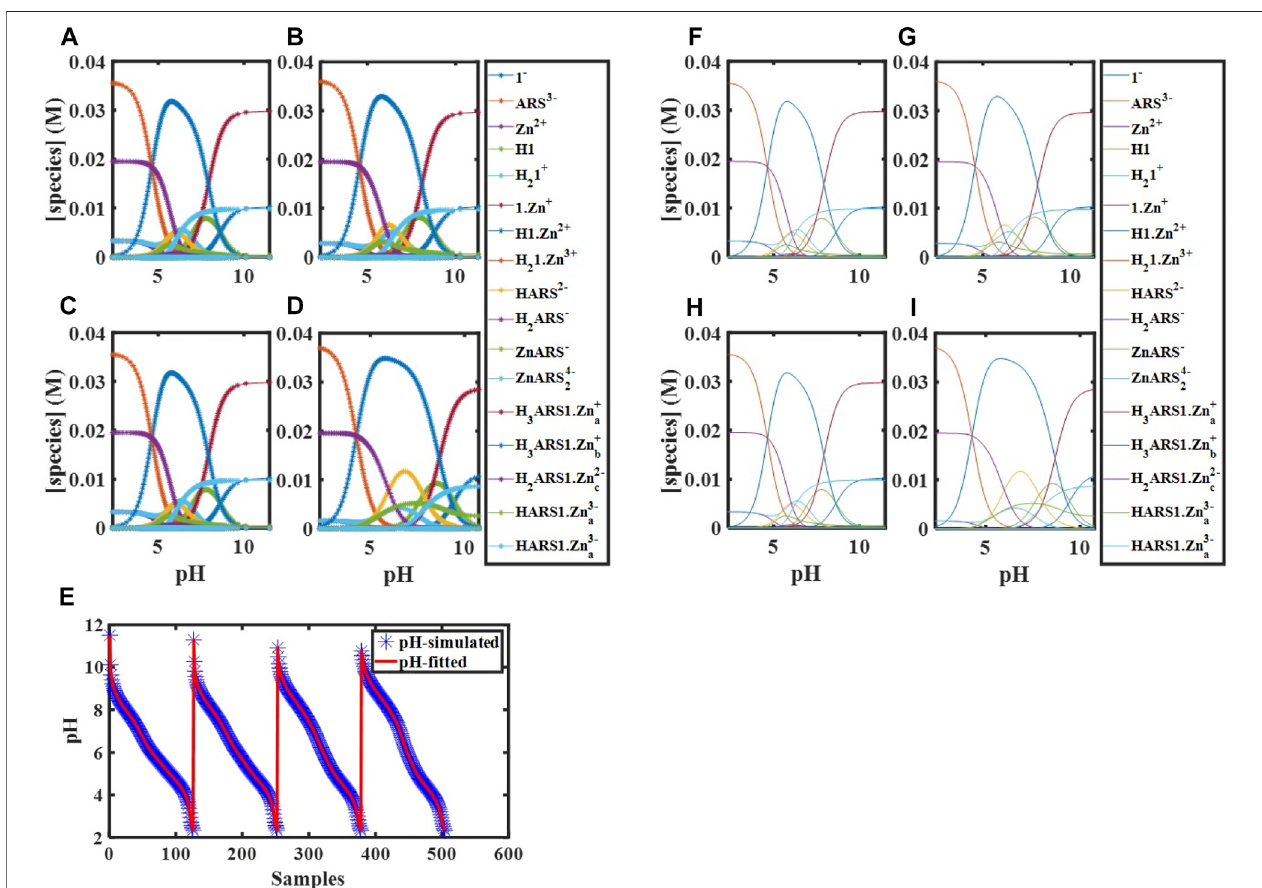
FIGURE 3 | Simulated concentration pro fi les for [ Zn ] 0 tot (cid:1) [ 1 ] 0 tot (cid:1) 40.00 mM, [ ARS ] 0 tot (cid:1) 20.00 mM, [ OH ] 0 tot (cid:1) 5 × 10 − 4 M at (A) 278 K, (B) 284 K, (C) 298 K, and (D) 308 K; (E) Simulated and fi tted pH for [ d